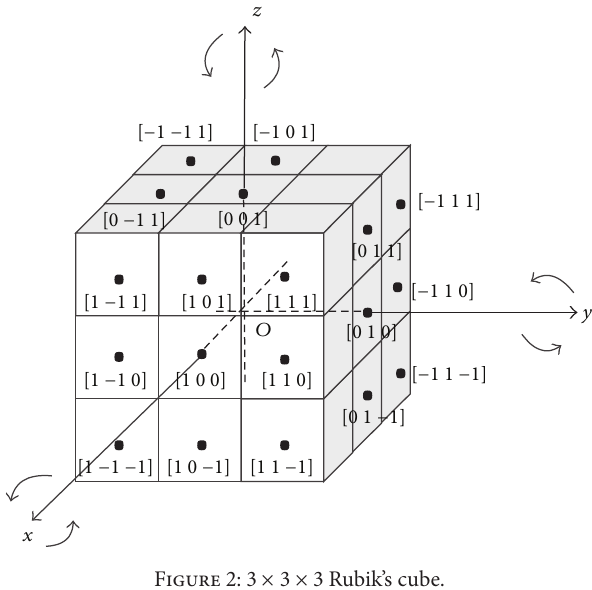
Figure 2: 3 × 3 × 3 Rubik’s